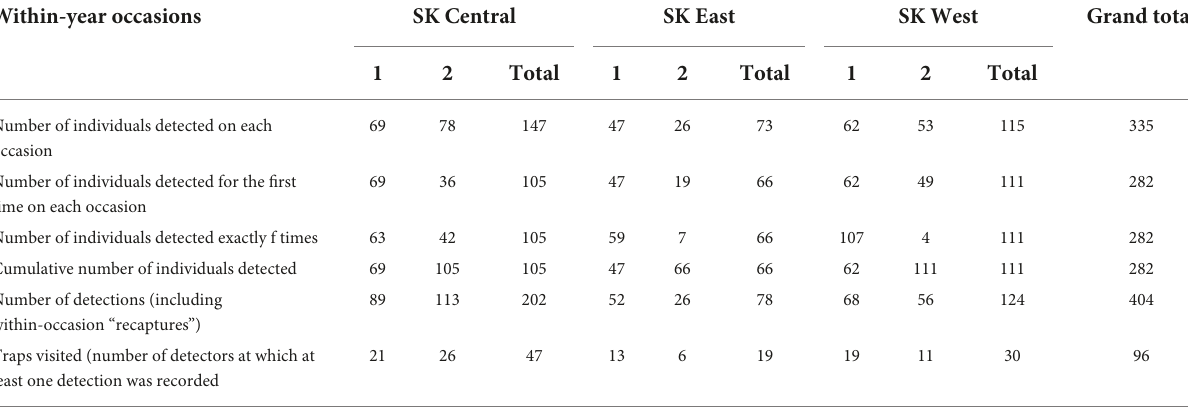
TABLE 2 Summary of spatial capture–recapture data used in the multi-spatial session model for estimating density. Within-year